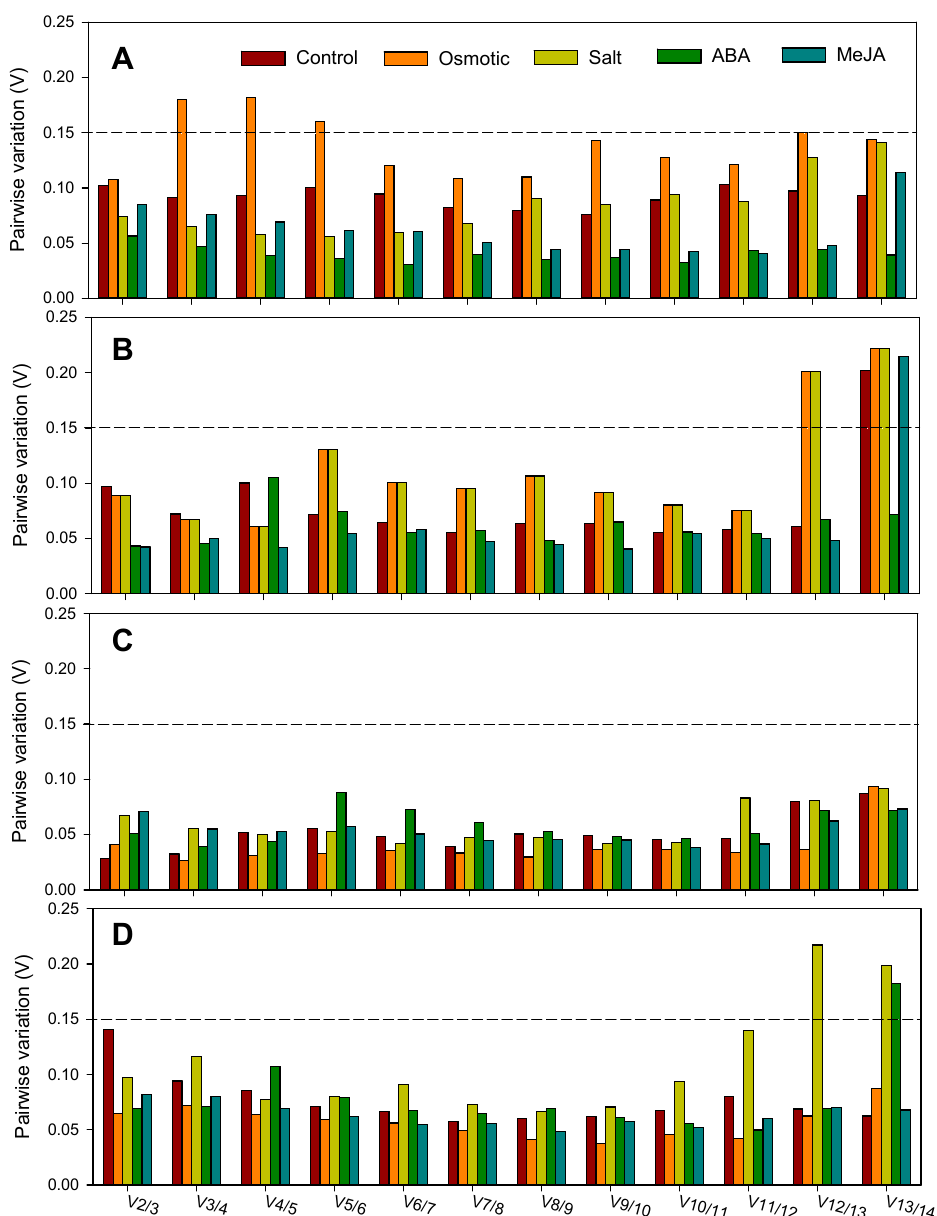
Figure 3. Pairwise variation analysis of the candidate reference genes of G. uralensis and G. inflata : the pairwise variation (V n / V n + 1 ) in the leaf ( A ) or root ( B ) of G. uralensis and the leaf ( C ) or root ( D ) of G. inflata . Pairwise variation analysis was conducted by geNorm procedure. V n / V n + 1 was calculated with the normalization factors NF n and NF n + 1 to determine the optimal number of reference genes required for quantitative real-time reverse transcription PCR (qRT-PCR) data normalization under different conditions.